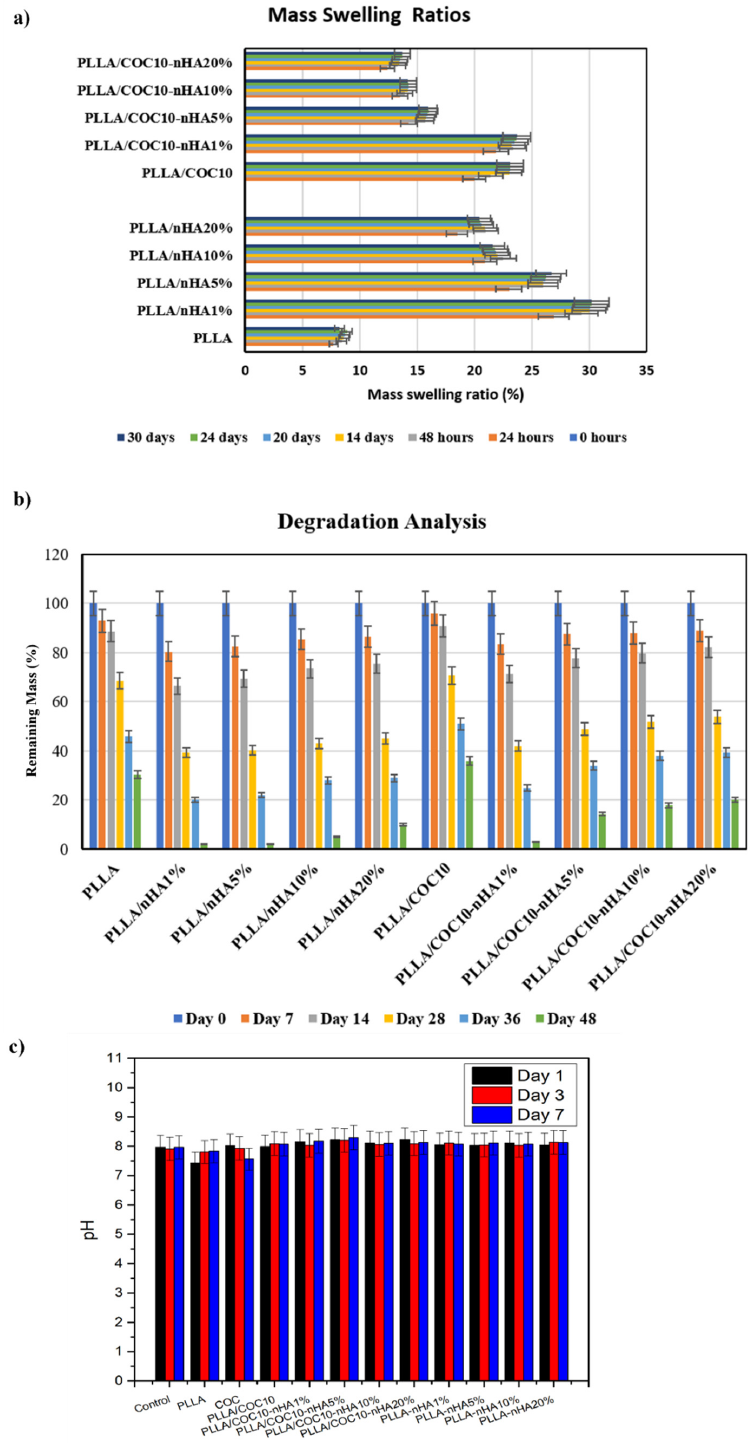
Figure 6. ( a ) Mass swelling ratios of nanocomposites. ( b ) Enzymatic degradation of nanocomposites. ( c ) pH values of nanocomposites with the passage of time. Nanocomposites had nHA in 1 wt%, 5 wt%, 10 wt%, and 20 wt%.